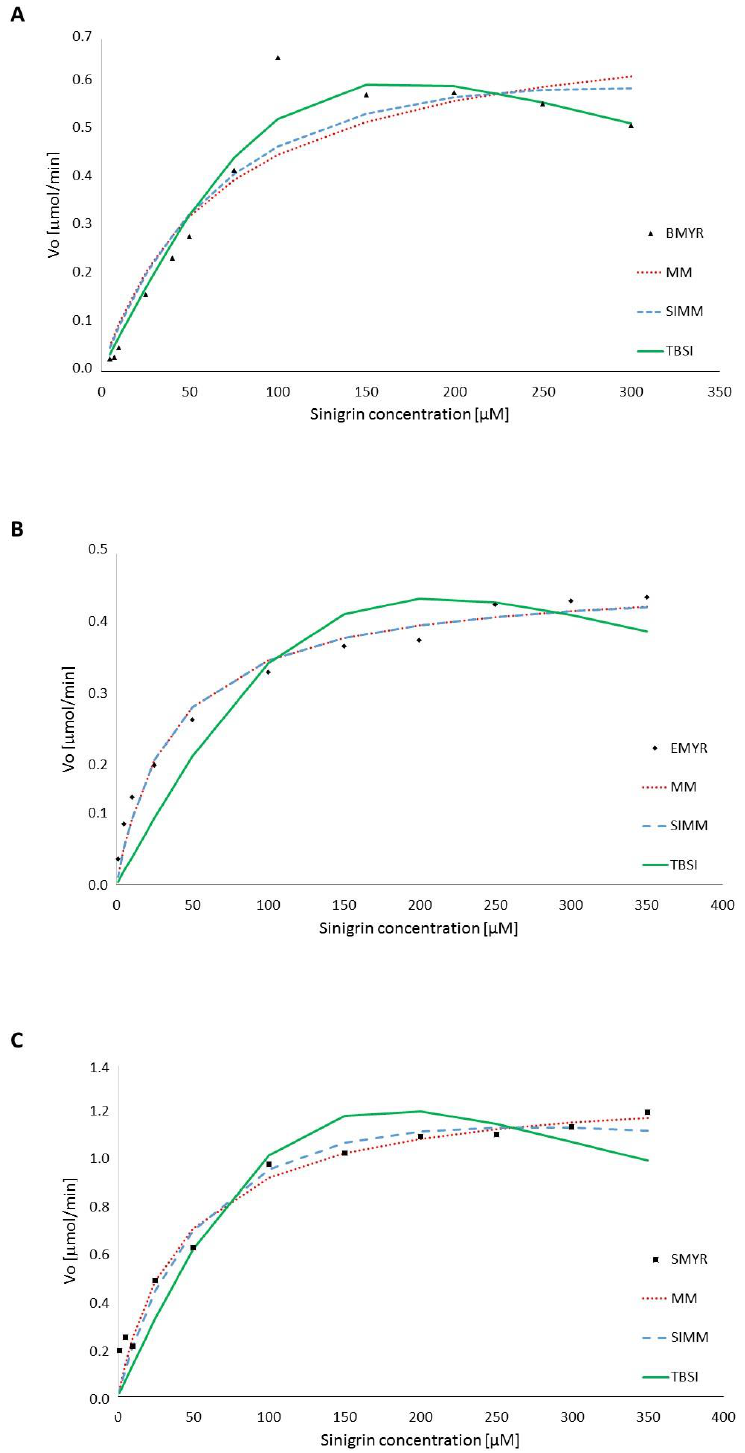
Figure 2. Adjustment of Michaelis–Menten (MM), Michaelis–Menten with substrate inhibition (SIMM), and two-binding-site inhibition model (TBSI) models to kinetics of ( A ) BMYR, ( B ) EMYR, and ( C ) SMYR.